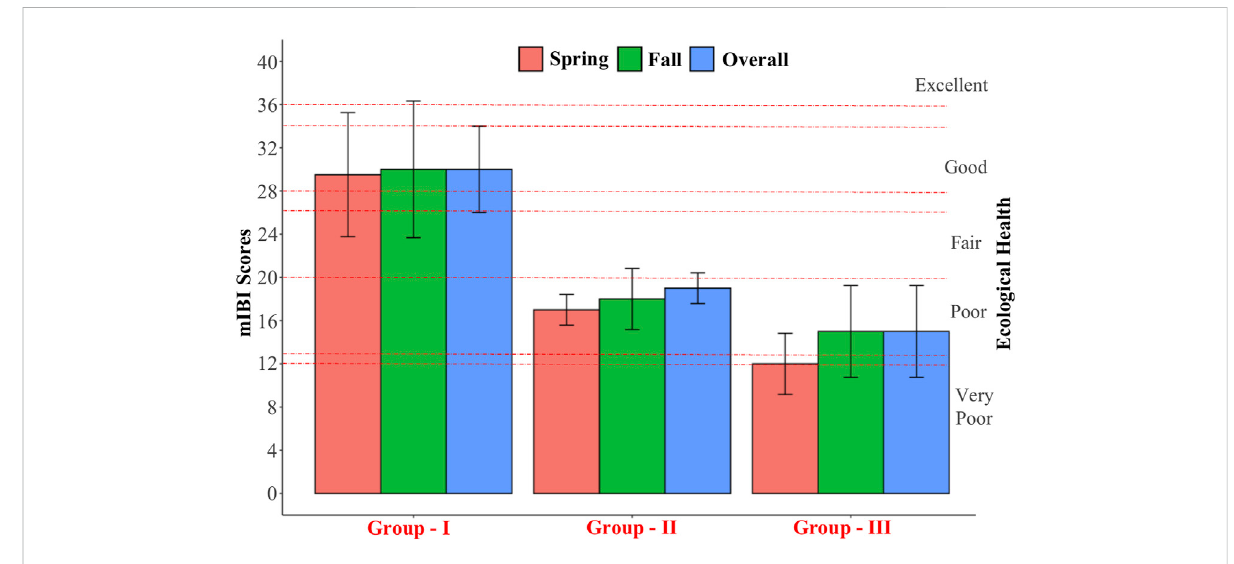
FIGURE 6 Ecological health assessment for the spatial water quality groups based on mIBI.